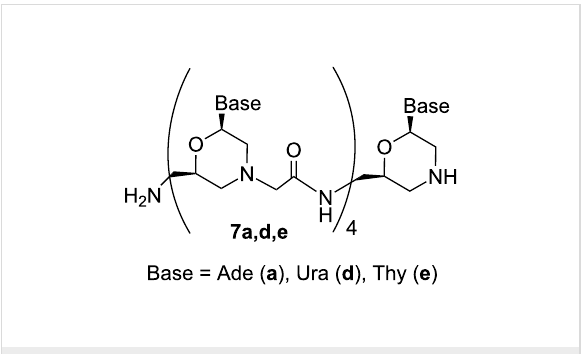
Figure 4: MorGly homopentamers containing adenine, uracil, and thymine nucleobases.